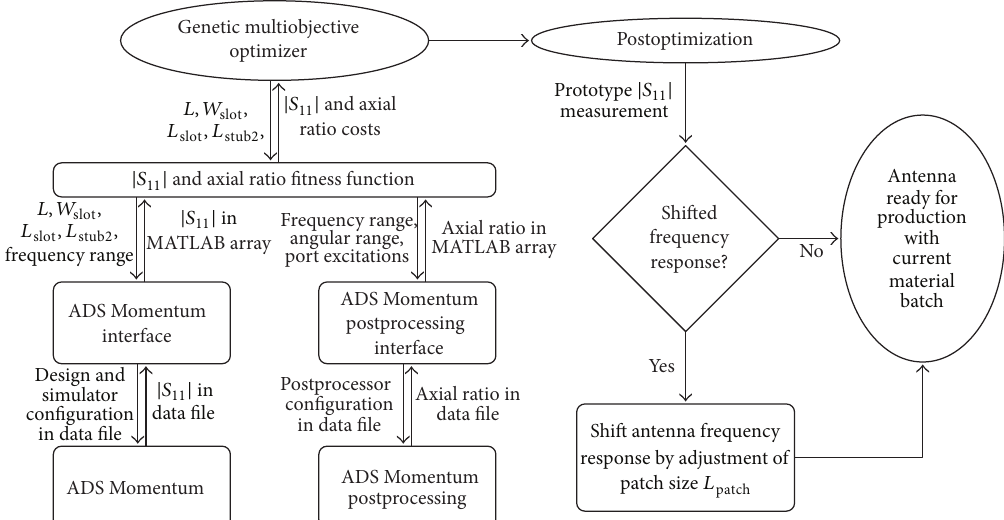
Figure 2: Dedicated optimization scheme for the design of the Galileo E6-band